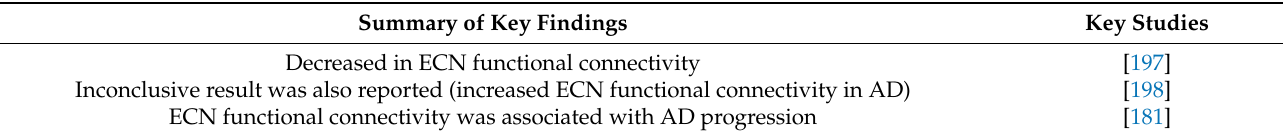
Table 4. Summary of key findings of rs-fMRI studies associated with the executive control network (ECN) in Alzheimer’s disease (AD) and mild cognitive impairment (MCI) patients included in the review. Summary of Key